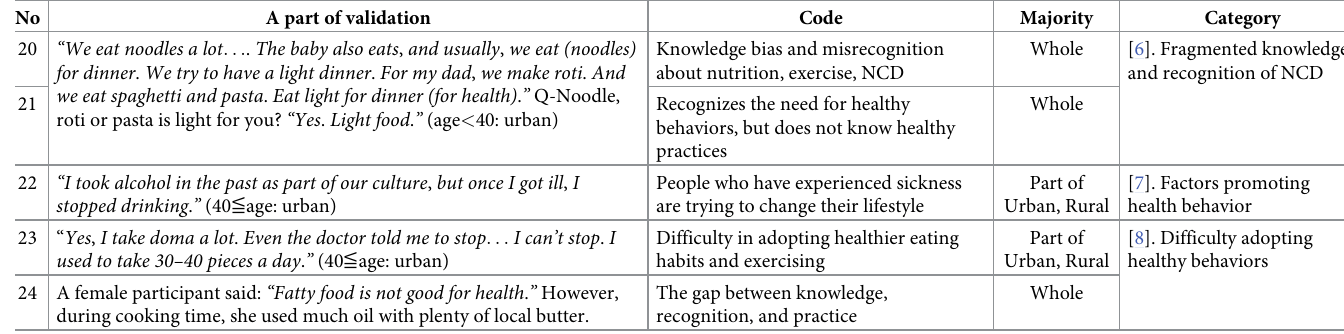
Table 7. Theme IV: Knowledge, recognition, and practice of prevention towards NCD: Validation, code, categories and themes. No